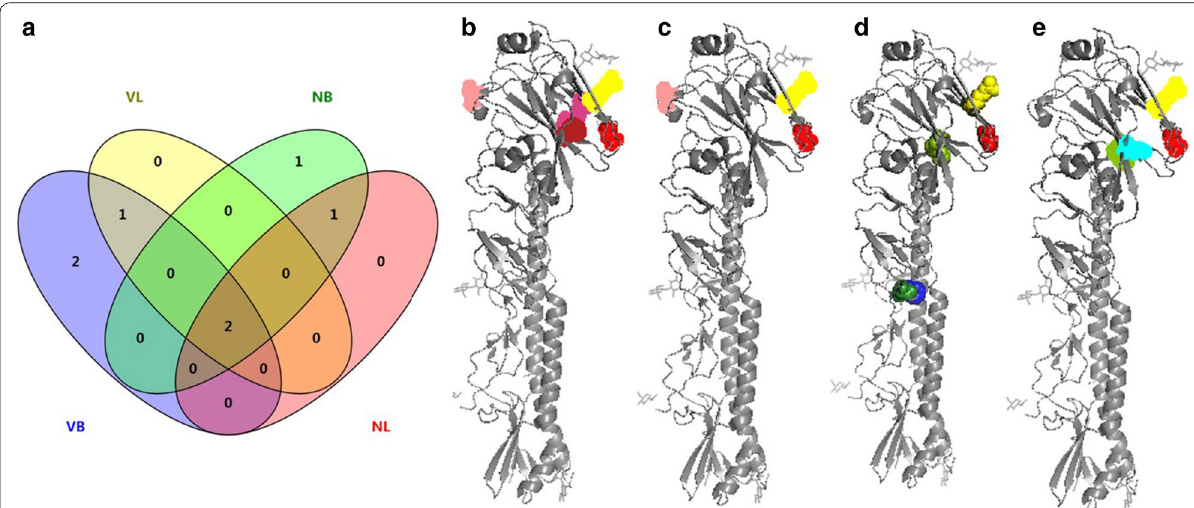
Fig. 4 Most frequently occurring mutations. a The statistics of the most frequently occurring variants. b – e Location of the most frequently occurring variants on the 3D structure. b VB; c VL; d NB; and e NL. Residues: 198: red; 234: yellow; 131: salmon; 168: firebrick; 201: warm pink; 114: